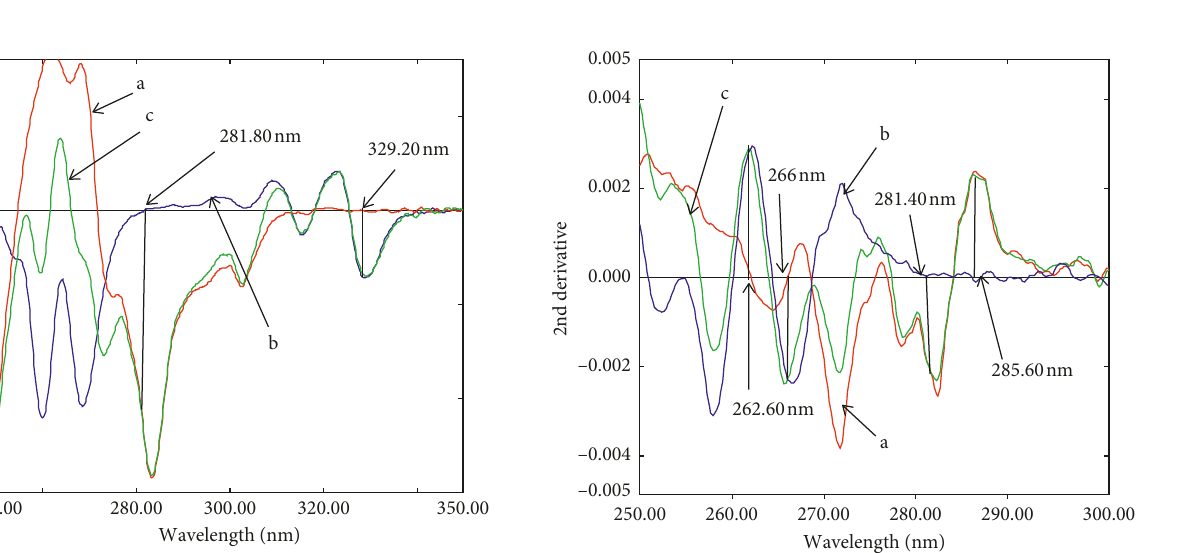
Figure 2: Zero-order spectra of (a) 10.0 μ g · mL − 1 of pyriproxyfen, (b) 3.0 μ g · mL − 1 of chlorothalonil, and (c) their mixture in methanol.